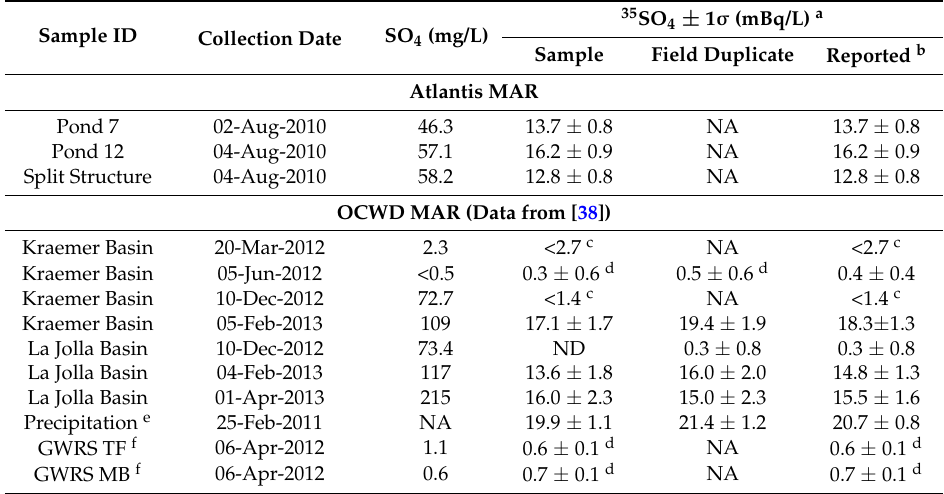
Table 1. [SO 4 ] and 35 SO 4 activities for source water and precipitation at the Atlantis and OCWD MAR sites.